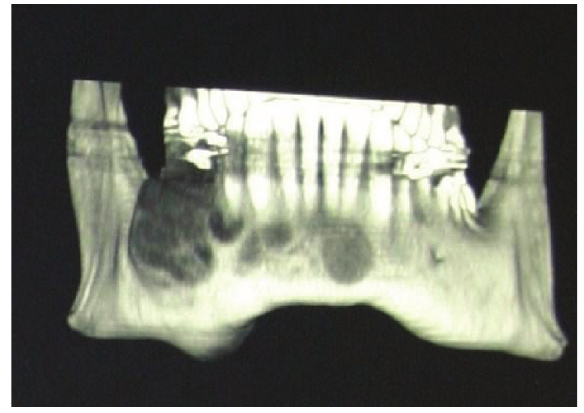
Figure 2: (May 29, 2001) TC deltascan shows the hypodense, disomogeneus borders neoformation with erosive character.